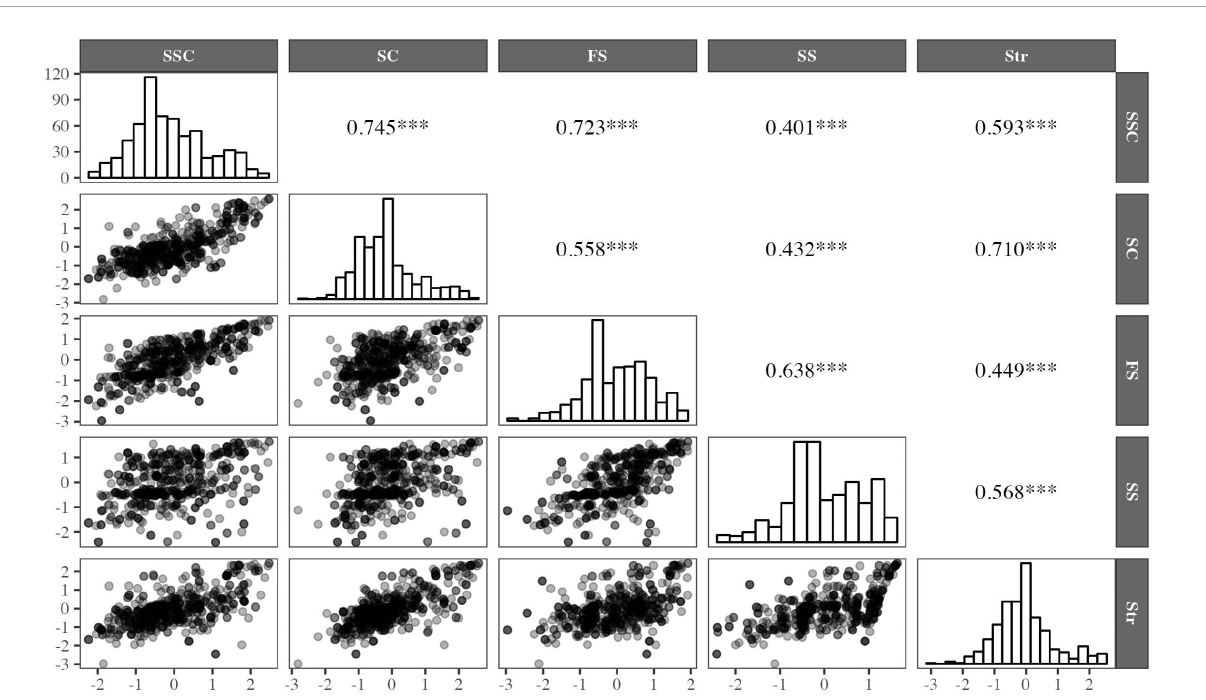
FIGURE3 Estimation of individual factor scores, their dispersion and Pearson’s correlation coefficient. SSC, Strength and Self-Confidence; SC, Social Competence; FS, Family Support; SS, Social Support; Str, Structure. ∗∗∗ p <